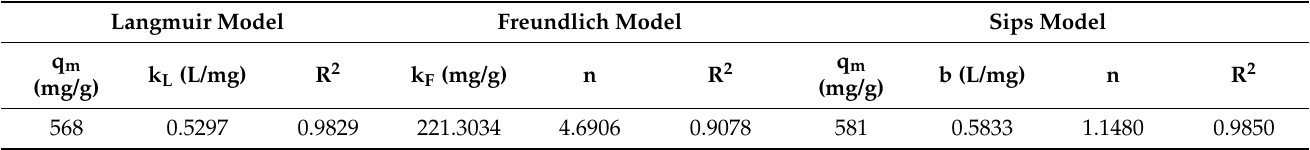
Figure 7. The experimental and the fitted isothermal adsorption curves for TC on P-POPs-3 by Langmuir, Freundlich and Sips models at 25 °C, respectively. Table 3. Parameters obtained from the Langmuir, Freundlich, and Sips models.